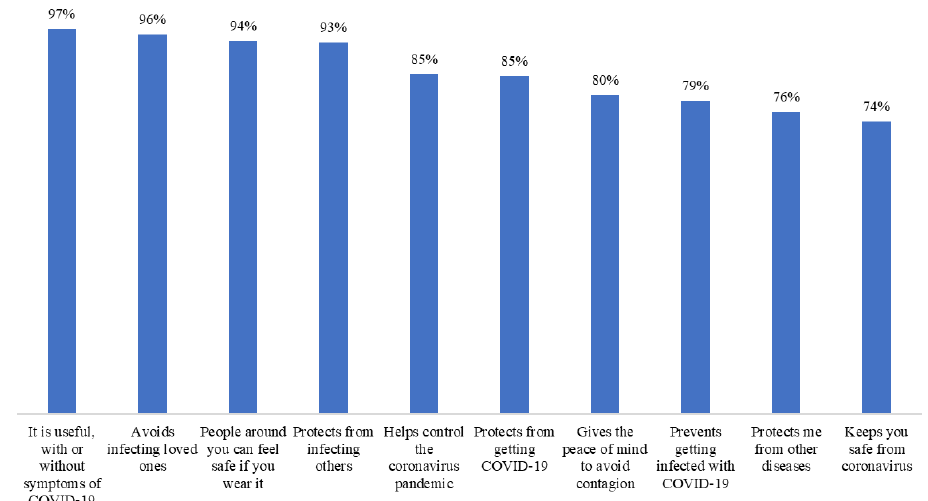
Figure 3. Perception of benefits of wearing face masks in patients with diabetes (n = 288).